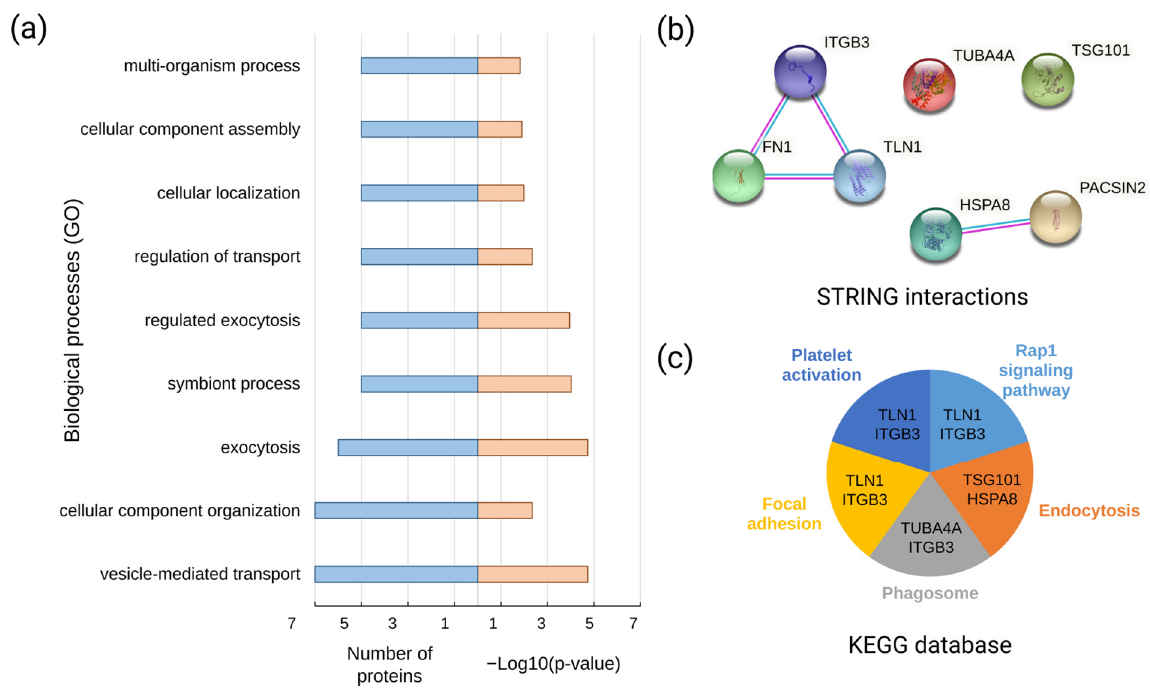
Figure 5. ( a ) The functional annotation of the EV proteomic signature components against categories of biological processes (Gene Ontology); ( b ) results of the STRING interaction analysis (PPI enrichment p -value: 0.0249) with the highest confidence (0.9) (the active interaction sources were experiments and curated databases); and ( c ) the functional annotation of the EV proteomic signature components against KEGG database pathways.